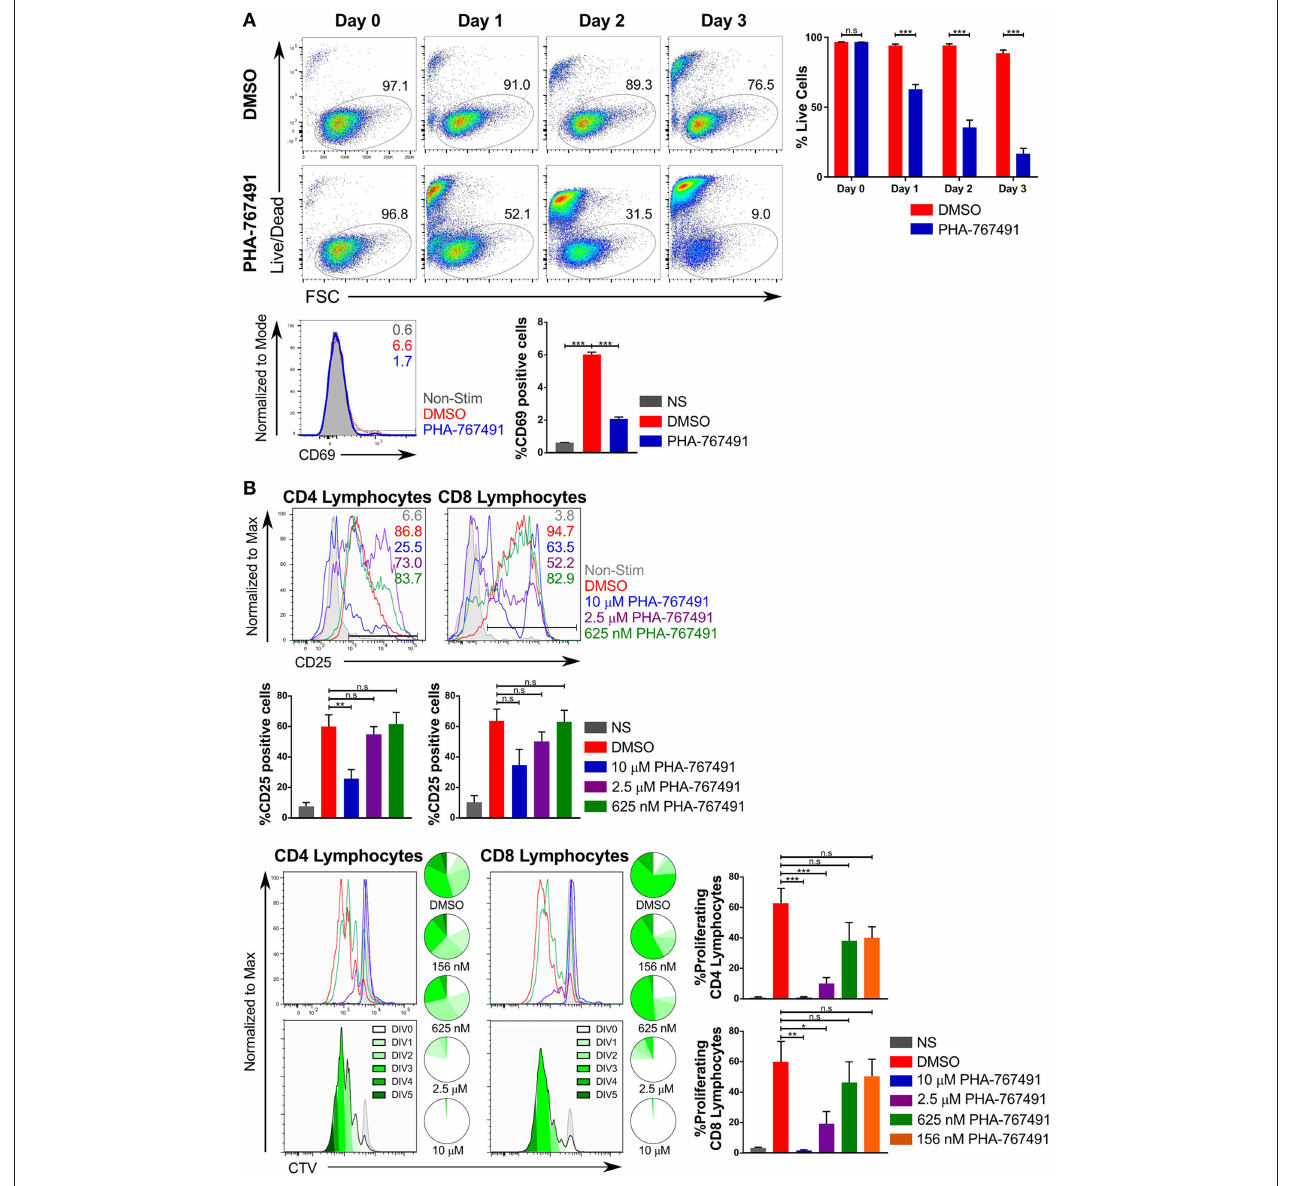
FIGURE 3 | PHA-767491 impedes cell proliferation. (A) (Top) PHA-767491 suppresses constitutive proliferation and activation of Jurkat cells. Jurkat cells that were not TCR stimulated were treated with either DMSO or PHA-767491 and incubated for 72h. A time course of Jurkat cell viability tracks the percentage of live Jurkat cells based on Live/Dead staining. (Bottom) Jurkat cells were stimulated with anti-CD3/CD28 antibody-coated beads for 3h. The percentages of the positive population of each sample are represented in each graph according to their respective colors. (B) PHA-767491 suppresses proliferation of stimulated mouse lymphocytes. Peripheral mouse lymphocytes were labeled with CTV and subsequently treated with either DMSO or PHA-767491, seeded onto plates coated with plate-bound anti-CD3 antibodies and incubated for 72h. The percentages of the positive population of each sample are represented in each graph according to their respective colors. Cell proliferation was assessed by quantifying CTV dilution. Pie charts show the proportion of cells in each peak of division. A darker shade of green is used for each subsequent round of division. Top panels show the CTV graphs of the different samples in their respective colors. Bottom panels use the trace of the DMSO-treated sample to illustrate the individual division peaks and the corresponding colors. Data shown is representative of at least three independent experiments. Bar charts are represented as mean ± SEM. Statistical significance was determined by unpaired two-sided Student’s t -test (n.s, non-significant; * p < 0.05; ** p < 0.01; *** p <